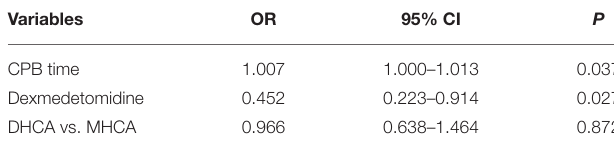
TABLE 2 | Results of the multivariable analysis of risk factors for sSIRS ( n = 600).